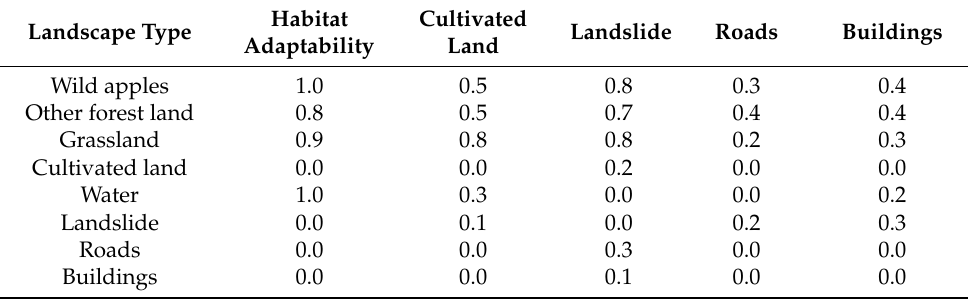
Table 4. Habitat adaptability of different landscapes and their sensitivity to various threat